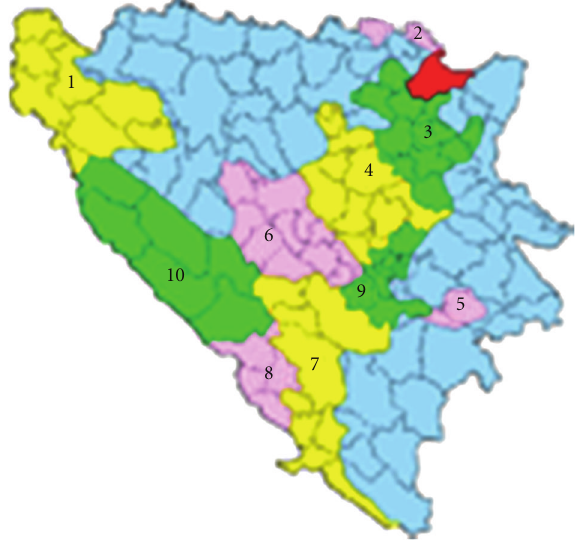
Figure 1: Map of Bosnia and Herzegovina; No 4-Tuzla